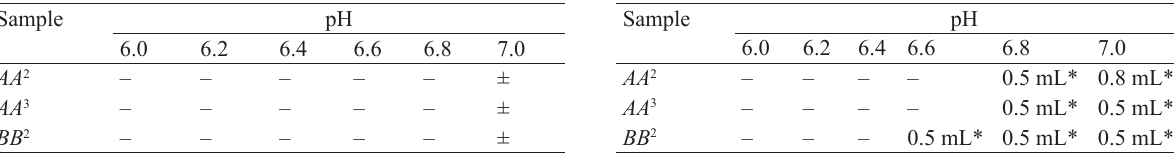
Table 8 Thermal stability of reconstituted dried milk from cows with different CSN3 genotypes by acid-boiling test